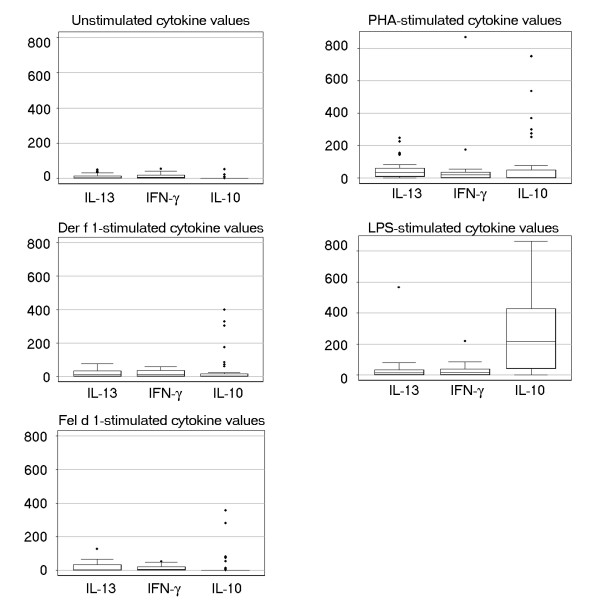
Secretion of IL-13, IFN-γ, and IL-10 cytokines by neonatal CBMCs. IFN-γ, IL-10, and IL-13 secretions were measured in unstimulated supernatants and supernatants after 24 hours' stimulation with allergens (Der f 1 and Fel d 1), phytohemagglutinin (PHA), and lipopolysaccharide (LPS). The median is represented by the black bar. The upper and lower boundaries of the box represent the 25th to 75th percentiles of the data, respectively. Observations < 1.5 times the height of the box beyond either quartile are displayed within the whiskers. (•) represents outliers.